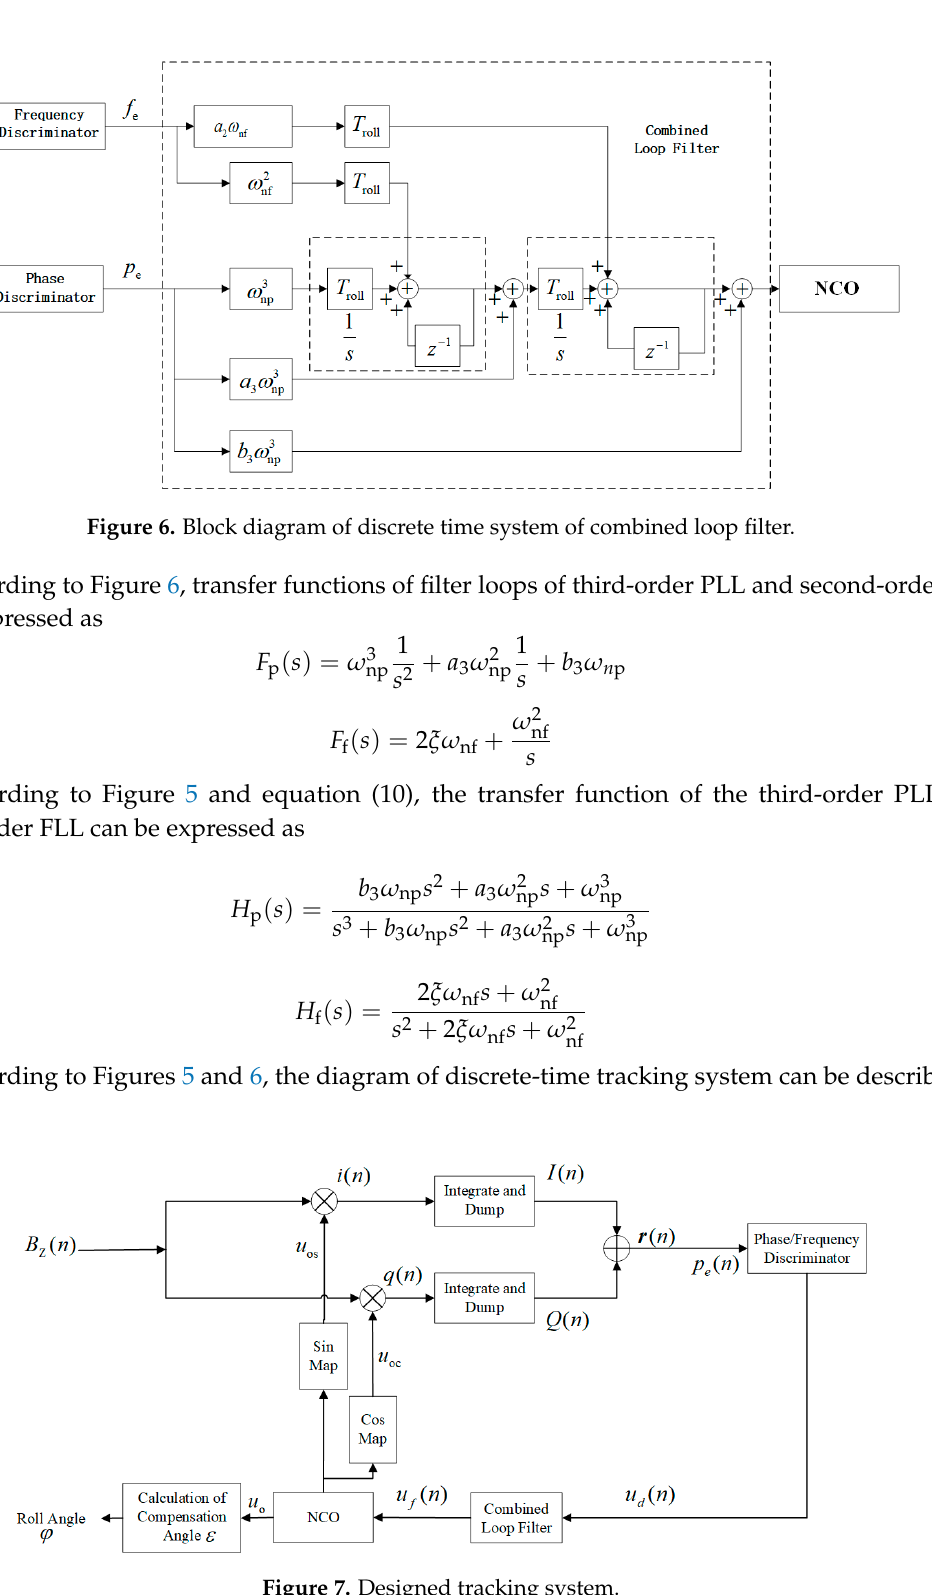
Figure 7. Designed tracking system.